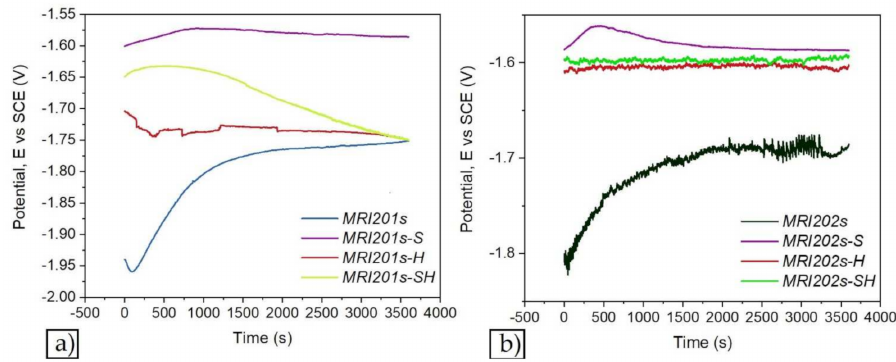
Figure 7. The open circuit potential curves of magnesium alloys: MRI201s alloy ( a ), MRI202s alloy ( b